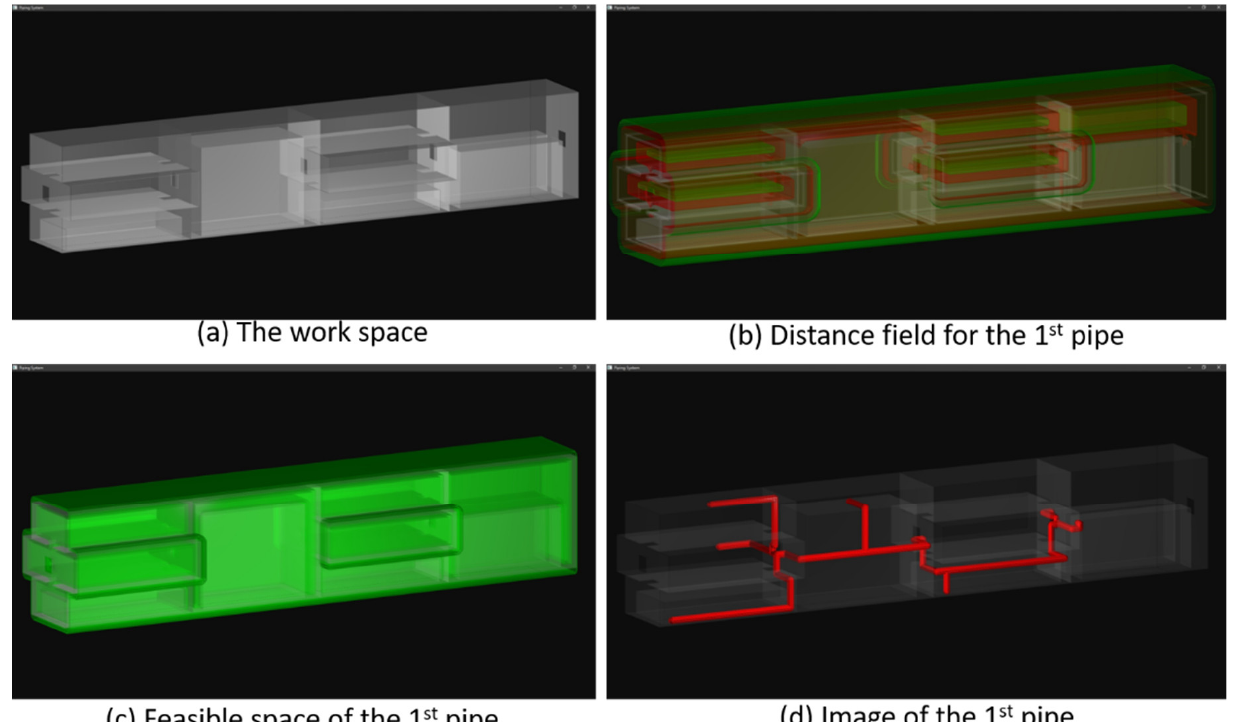
Figure 4. Routing the 1st pipe inside the underwater vehicle, ( a ) internal structure of the domain, ( b ) two levels in the distance field, shaded in green and red colors, ( c ) the feasible space, shaded in green color, and ( d ) the resultant pipe, shaded in red color. Table 1. Geometrical information of the workspace.